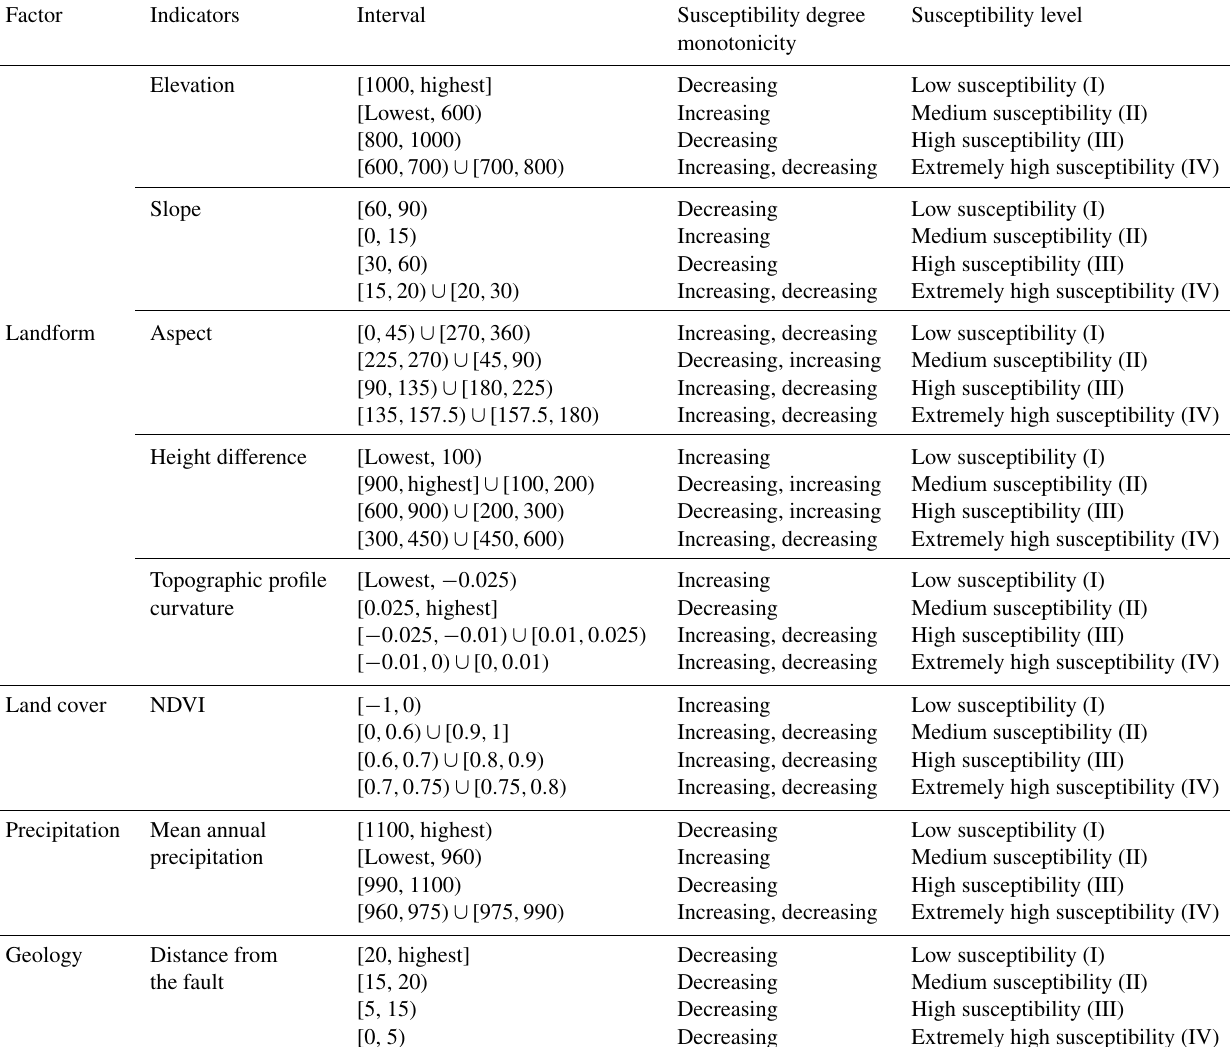
Table A1. Classification of landslide susceptibility grade corresponding to different